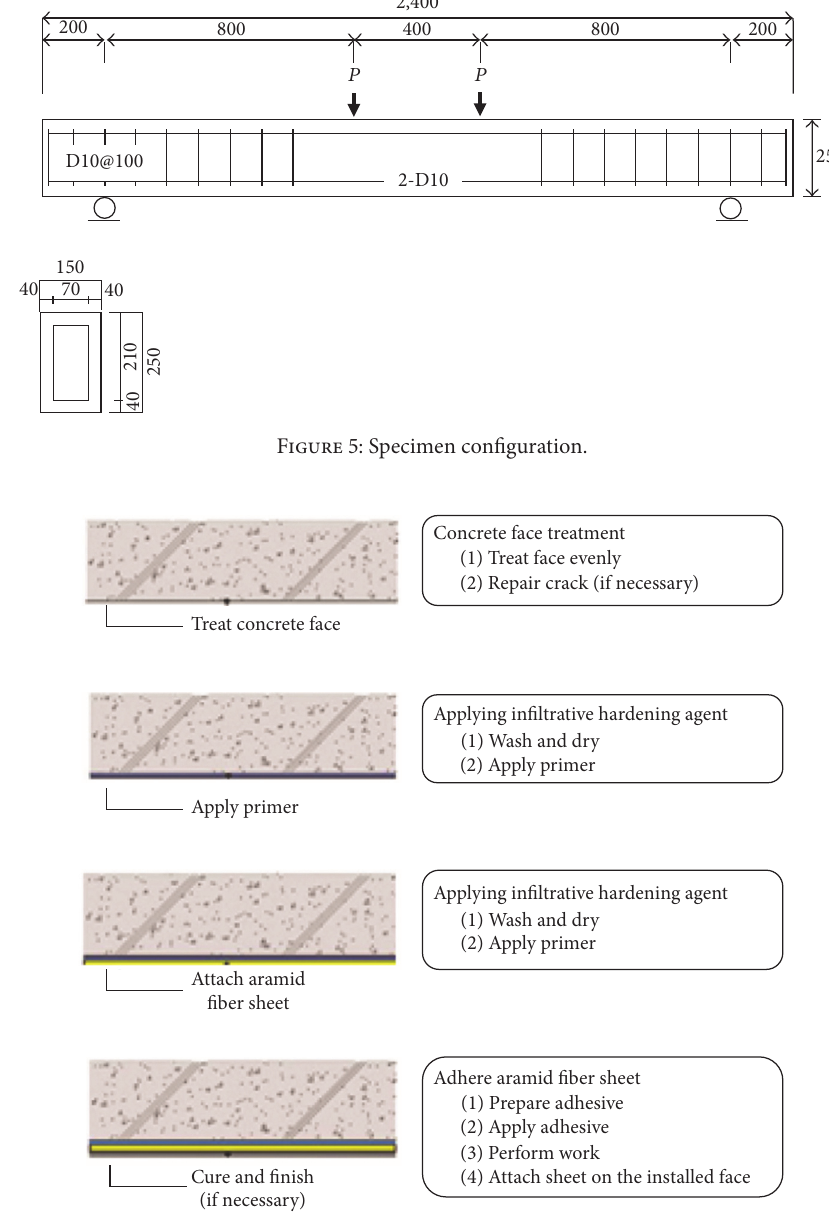
Figure 6: The procedure of installing aramid fiber